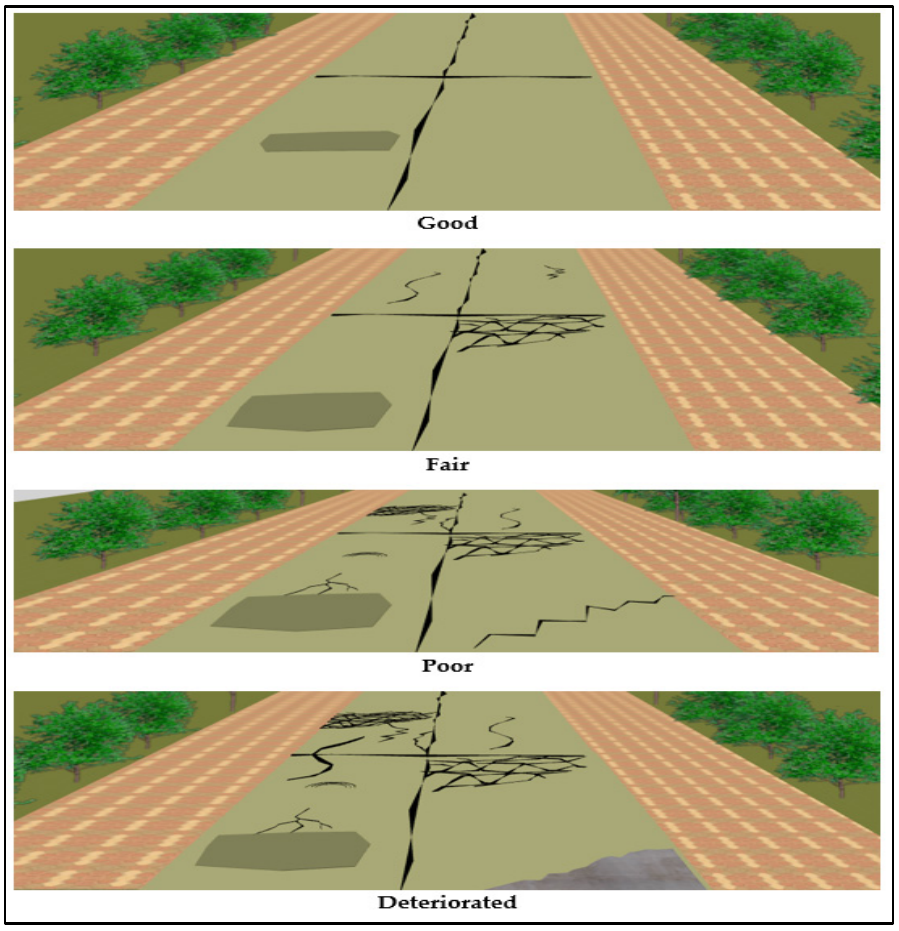
Figure 1. Visual evaluation of HMA pavement. Adapted/Redrawn from Ref. [7].